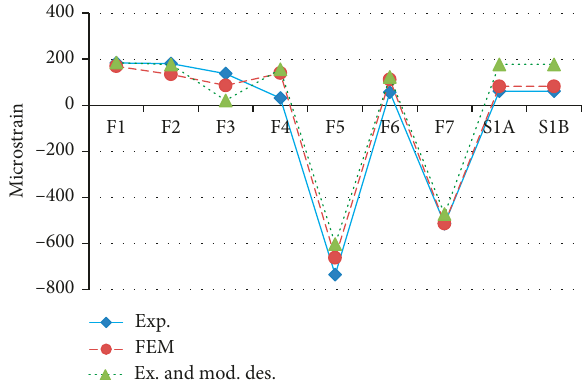
Figure 6: Strain values due to the concrete arch pour (stage